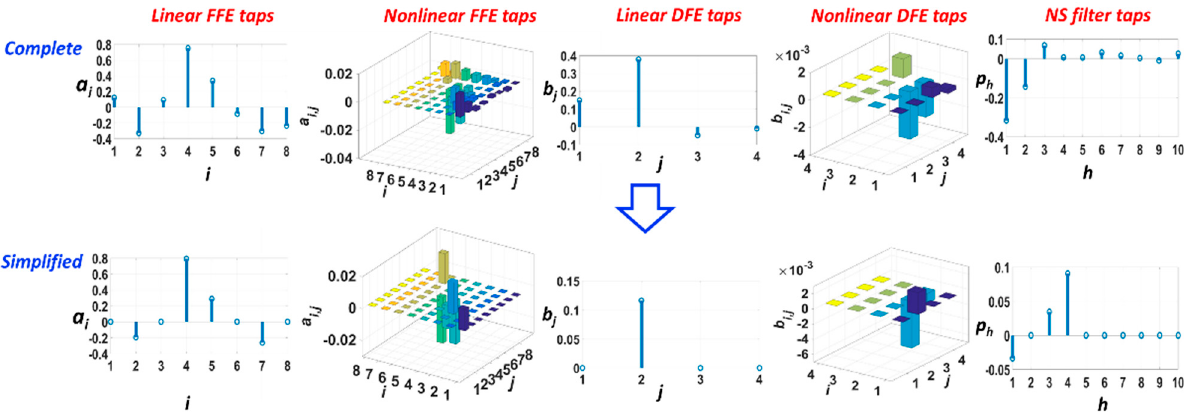
Figure 5. Feedforward and decision feedback equalizer (FFE/DFE) and noise suppression (NS) filter tap coefficients for full DSP and simplified DSP cases with 20 km SMF at an optical power of − 21 dBm.